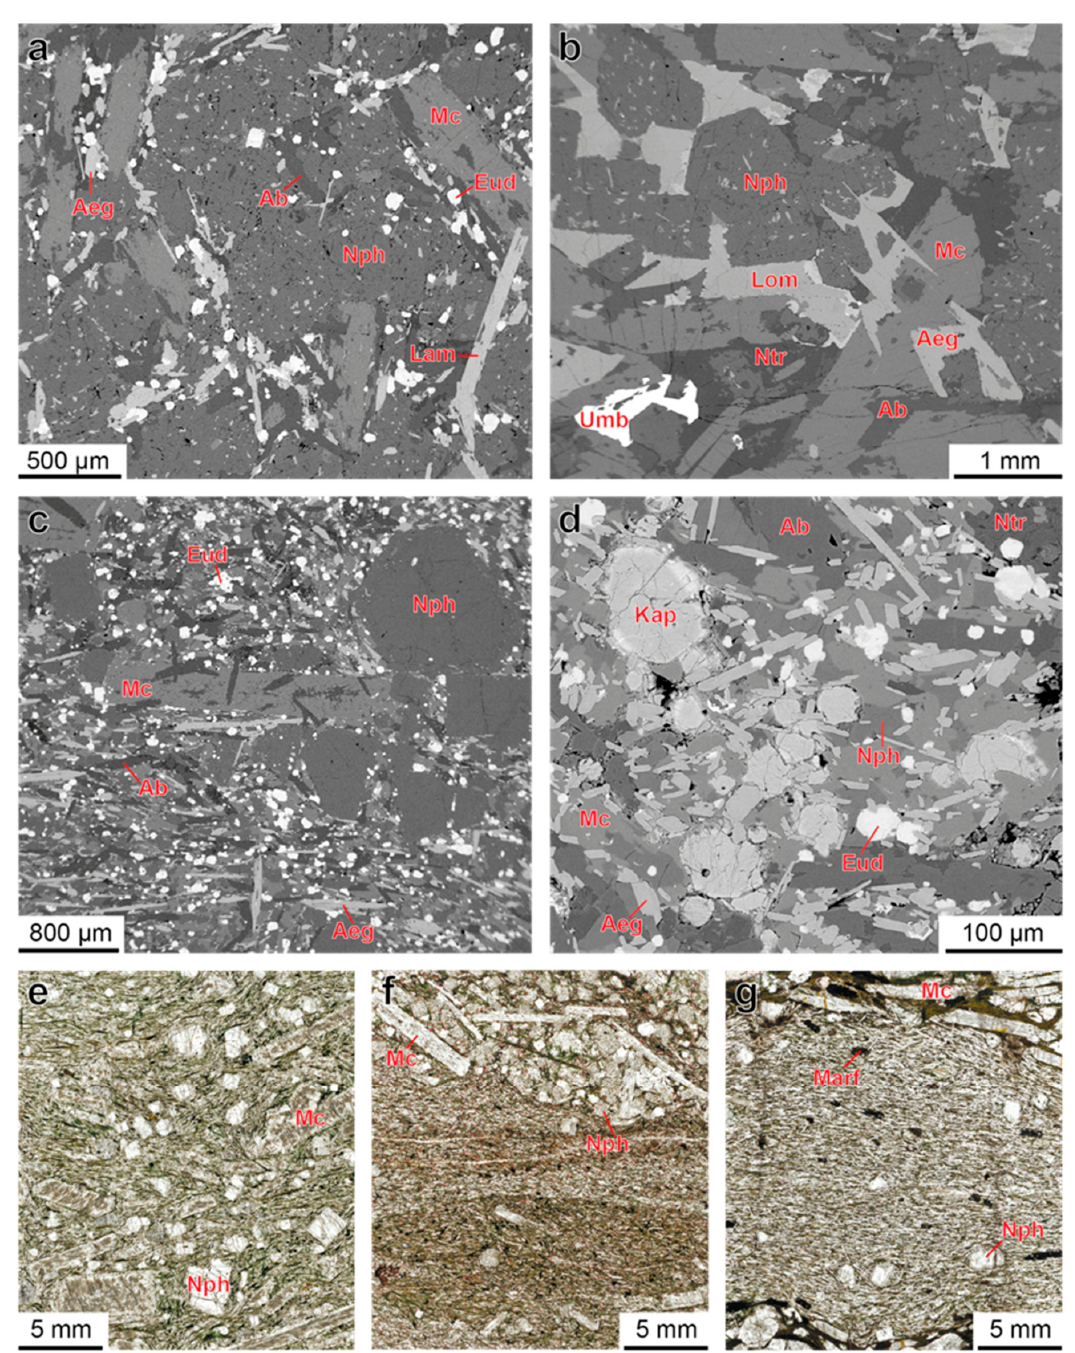
Figure 4. Leucocratic rocks of the Alluaiv site: ( a )—BSE-image of urtite 117/208; ( b )—BSE-image of foyaite 154/300; ( c )—BSE-image of fine-grained foyaite 157/36; ( d )—BSE-image of kapustinite-rich fine-grained foyaite 32/243; ( e , f )—images in transmitted light of polished thin sections of porphyry foyaite 154/253 ( e ); contact of fine-grained foyaite (below) and urtite 154/216 ( f ); vein of fine-grained foyaite in malignite 157/36 ( g ).